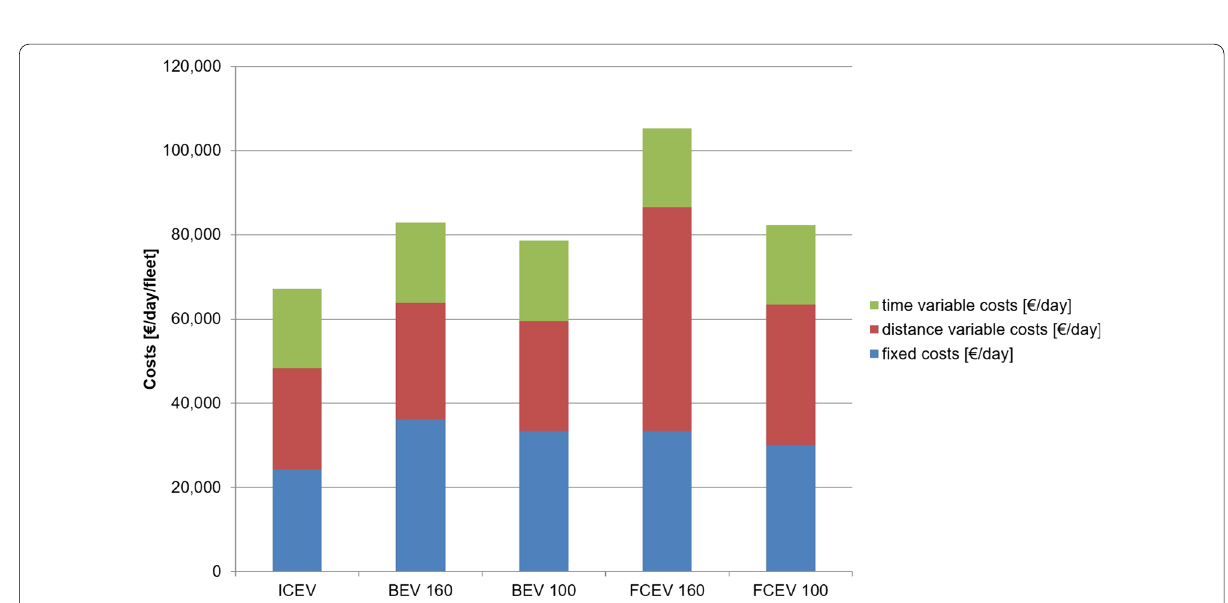
Fig. 7 Total cost of ownership for the considered